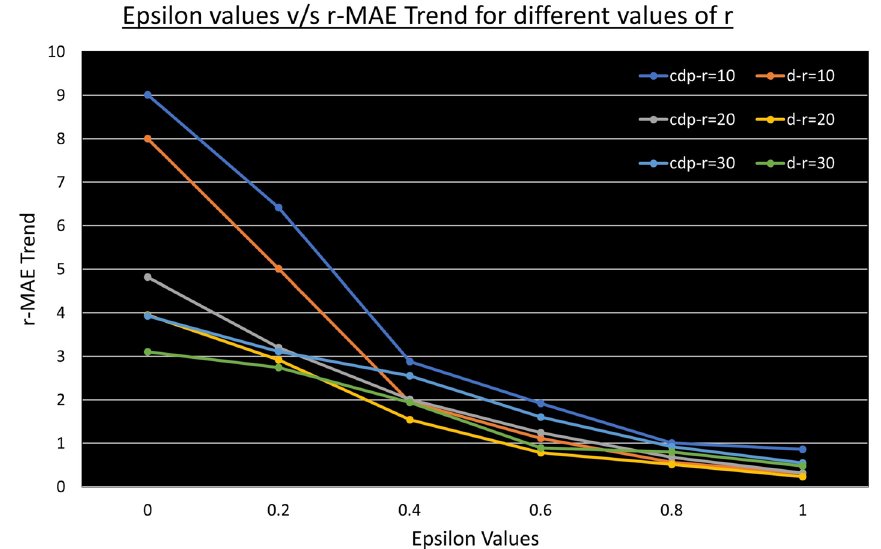
Fig. 9 Epsilon versus r-MAE trend for the different